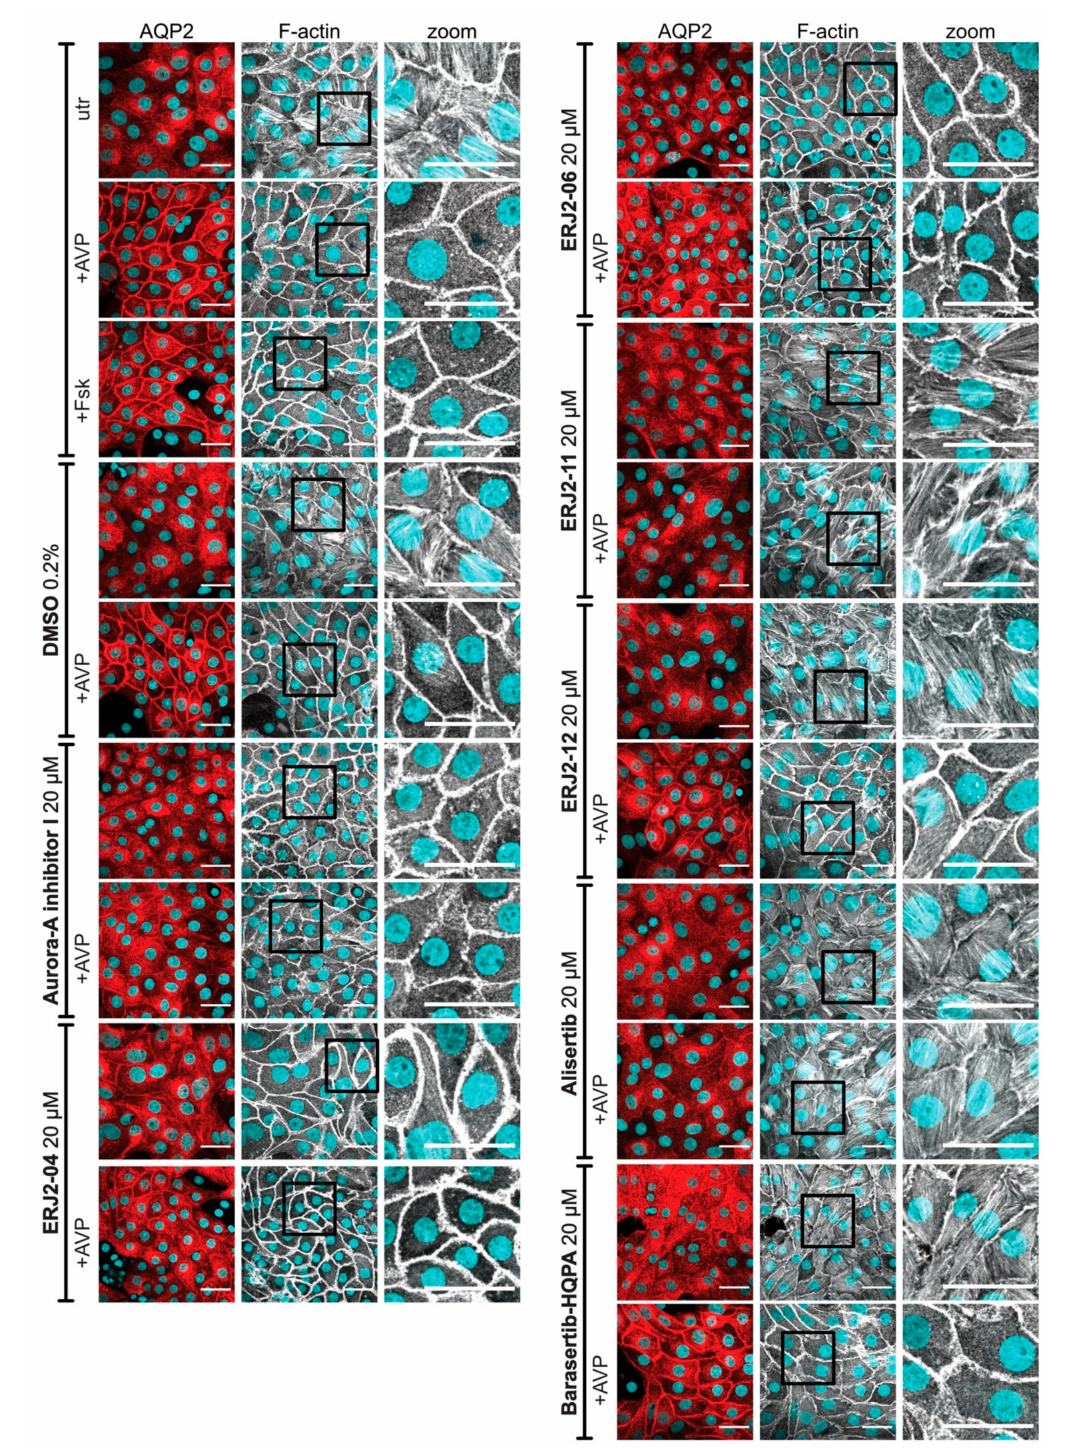
Figure 9. AURKA inhibitors affect the organization of actin stress fibers in primary IMCD cells. Primary IMCD cells were left untreated (utr) or treated with DMSO (0.2%, 1 h) or compound (20 µ M, 1 h) alone or in combination with forskolin (Fsk; 30 µ M, 30 min) or arginine-vasopressin (AVP; 100 nM, 30 min). AQP2 was detected by immunofluorescence microscopy using specific primary antibody (AQP2, E-2) and Cy3-coupled anti-mouse secondary antibody (red). F-actin was stained using an iFluor 488-conjugated phalloidin (grey). Nuclei were stained with DAPI (cyan). Shown are representative images of three independent experiments; scale bar 30 µ m. Magnified views (zoom) of actin stress fibers are from the indicated